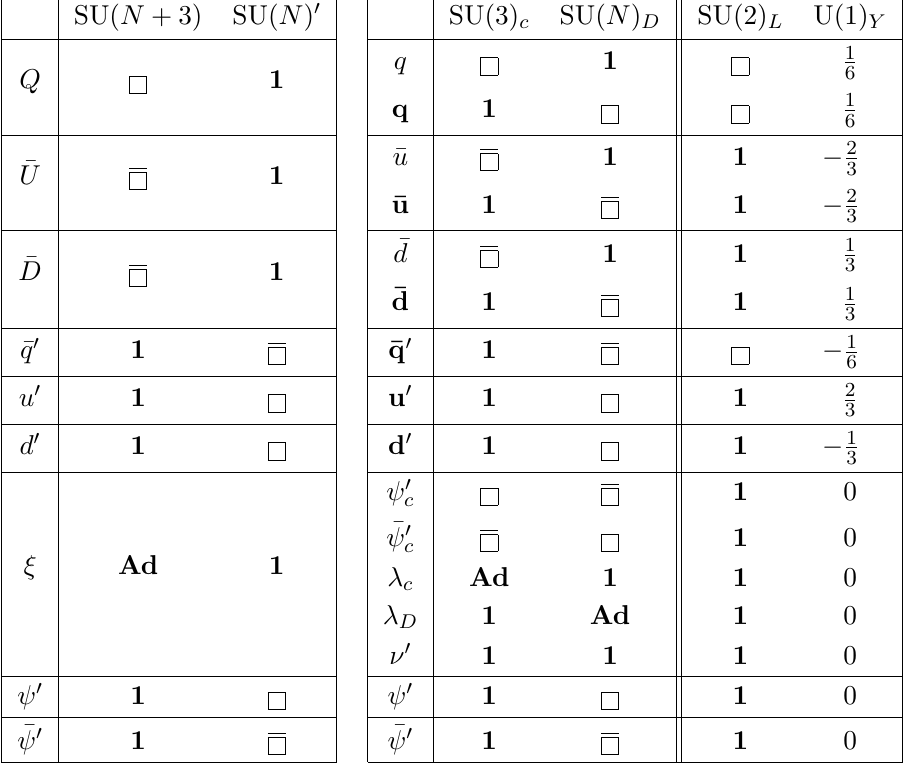
Table 3. The Weyl fermion content of the model, including the Standard Model quarks ( q, ¯ u, ¯ d ), charged under the various gauge groups. All listed fermions are singlets of either hypercolor gauge groups. The Weyl fermion, ξ is listed as an adjoint of SU ( N + 3) , but as discussed in the text, can also be in a pseudoreal representation of SU ( N + 3) for N = 3 , 7 , . . . . by the hyperfermion dynamics at a higher scale compared to the color breaking scale. 1 This means that there is an effective Yukawa coupling of the Higgs to the quark parents. After color breaking, this Yukawa coupling